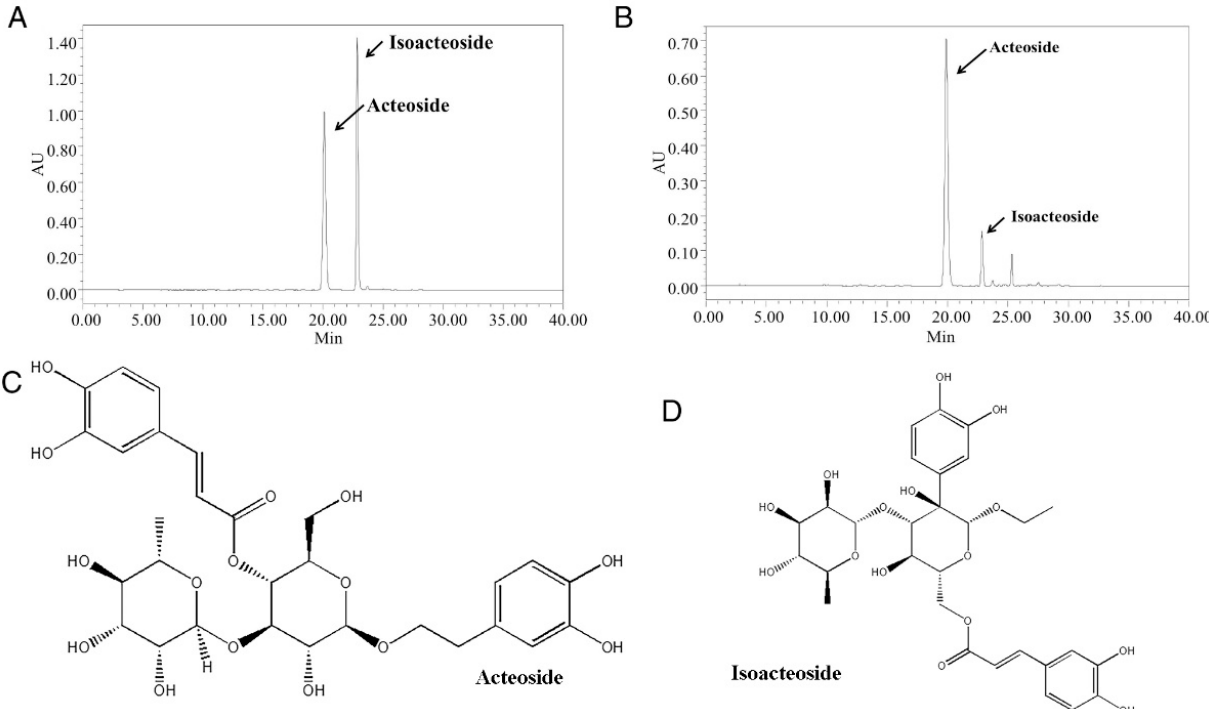
Figure 2. HPLC chromatogram of CAO and chemical structures of two glycosides. ( A ) HPLC chromatogram of CAO in 330 nm. ( B ) HPLC chromatogram of acteoside and isoacteoside stand- ard in 330 nm. ( C ) The chemical structure of acteoside. ( D ) The chemical structure of isoacteoside. AU, arbitrary units; CAO = callus of A. distichum var. Okhwang 1.